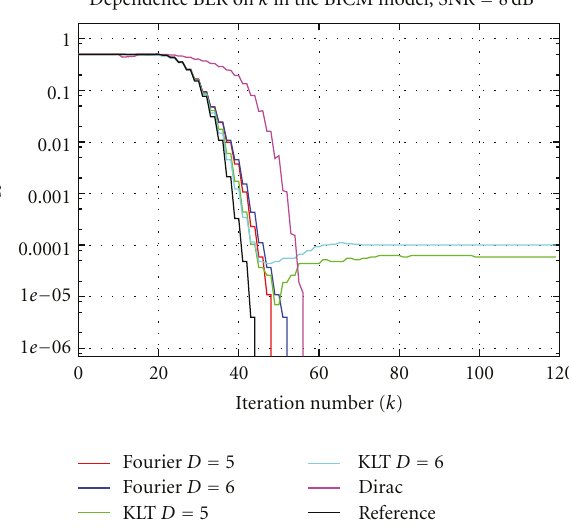
Figure 9: Bit error rate as a function of dimension for various message representations.